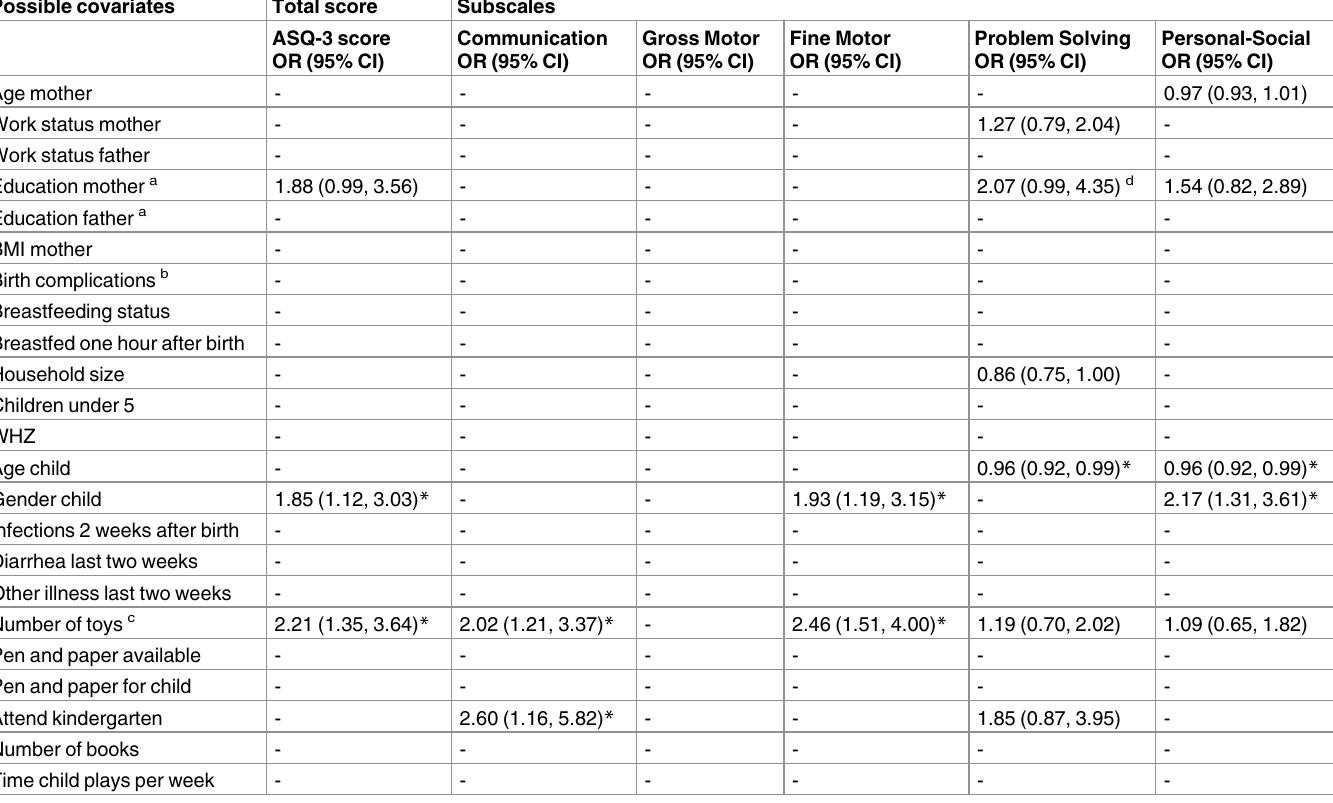
Only covariates significantly associated with an outcome in the crude model were included in the multiple regression. Variables significantly associated with the dependent variable in multiple models are marked with “ *